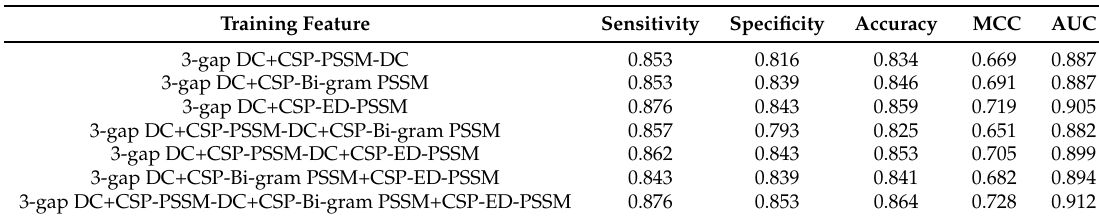
Table 3. The performance of models trained with combined